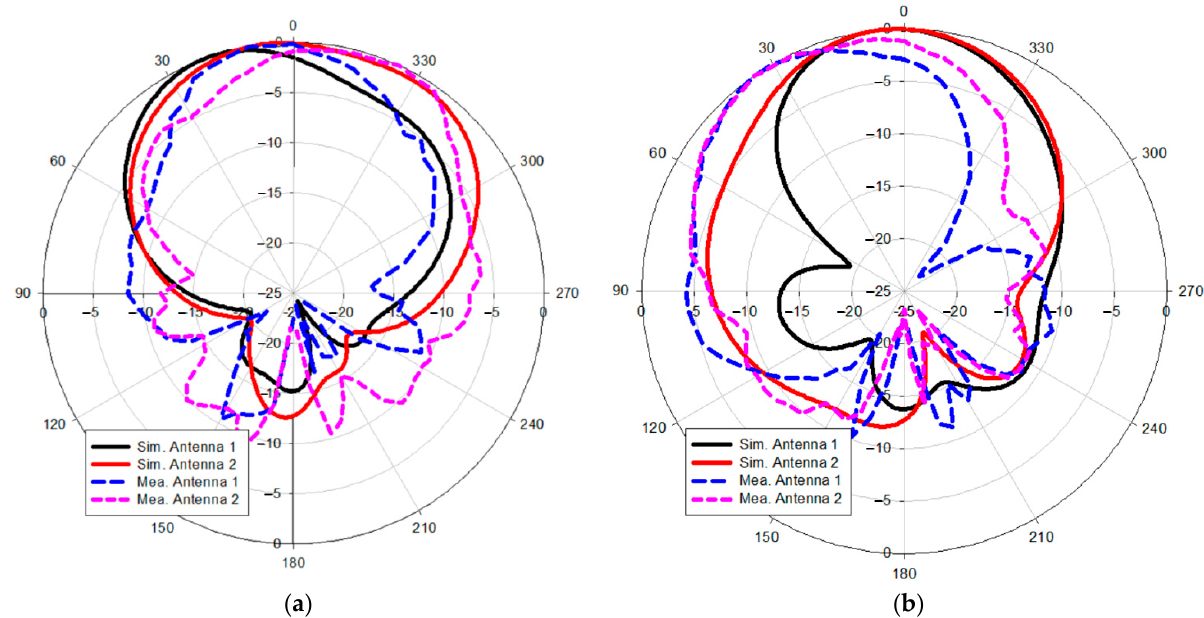
Figure 12. Measured and simulated radiation pattern for MIMO antenna: ( a ) E-plane and ( b ) H-plane .